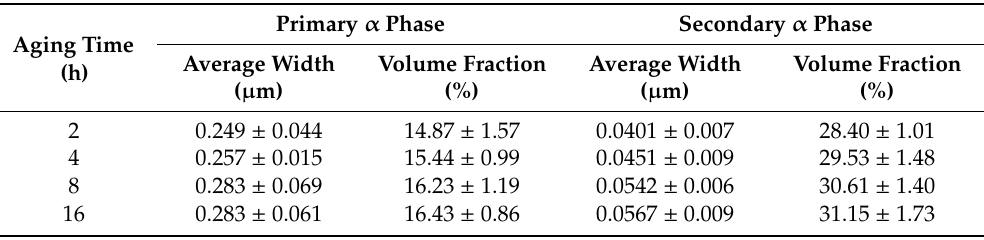
Table 1. Microstructure features of the α phase that was solution-treated at 780 ◦ C for 1 h plus aging at 540 ◦ C for di ff erent lengths of